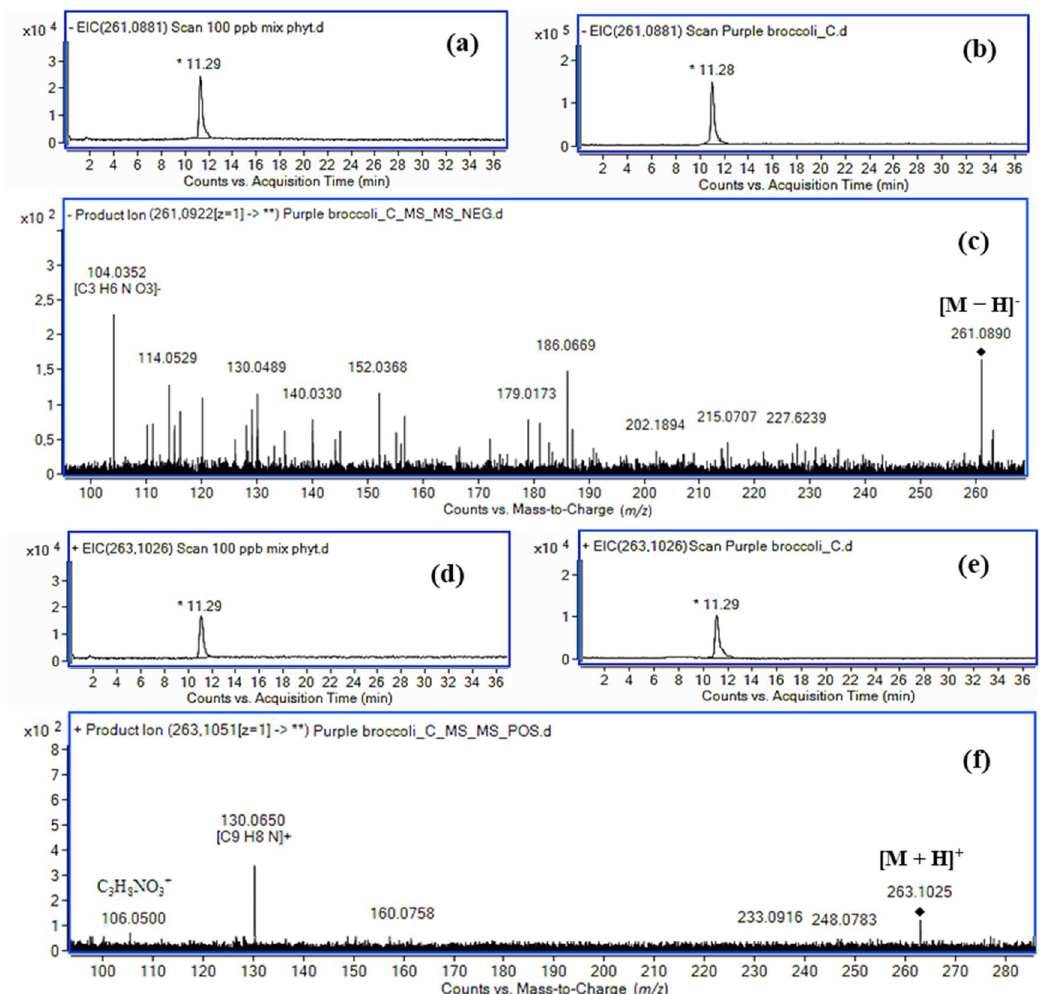
Figure 6. Extracted ion chromatograms for ( a ) a standard solution of IASer, ( b ) a purple broccoli extract, and ( c ) an MS / MS spectrum of the extract in negative ionization mode. Extracted ion chromatograms for ( d ) a standard solution of IASer, ( e ) a purple broccoli extract, and ( f ) an MS / MS spectrum of the extract in positive ionization mode.